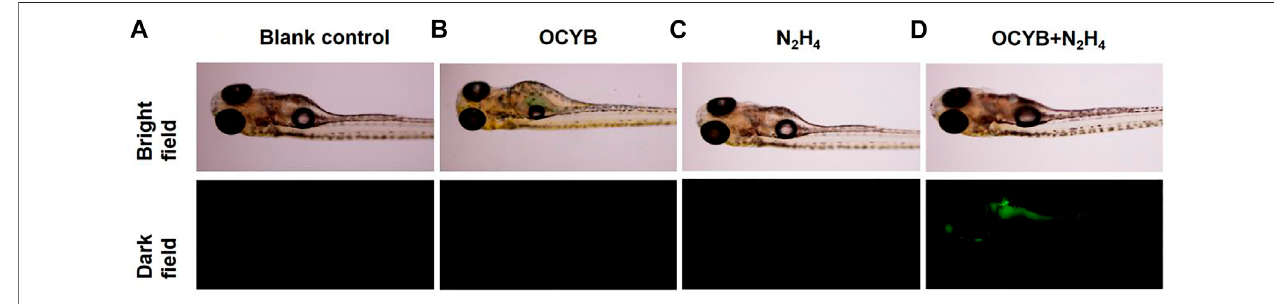
FIGURE 7 | Fluorescence images of zebra fi sh: (A) blank control. (B) OCYB. (C) zebra fi sh incubated with N 2 H 4 (100 μ M) for 30 min (D) zebra fifi sh samples pretreated with